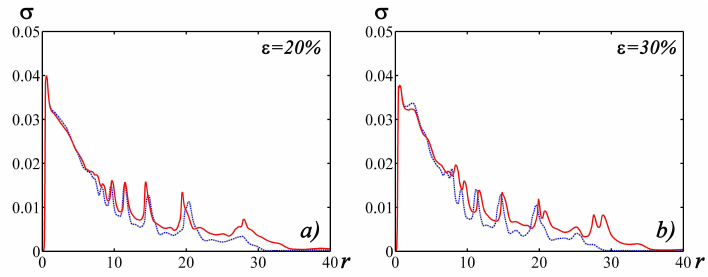
Fig. 5. Gas density distribution σ ( x, y ) along the x - (the dotted lines) and y -axis (the solid lines): (a) ε = 0 . 2, ε ρ = 0 . 11; (b) ε = 0 . 3, ε ρ = 0 . 2, where ε ρ is the gas density non-axisymmetry and ε is the non-axisymmetry of the DM halo